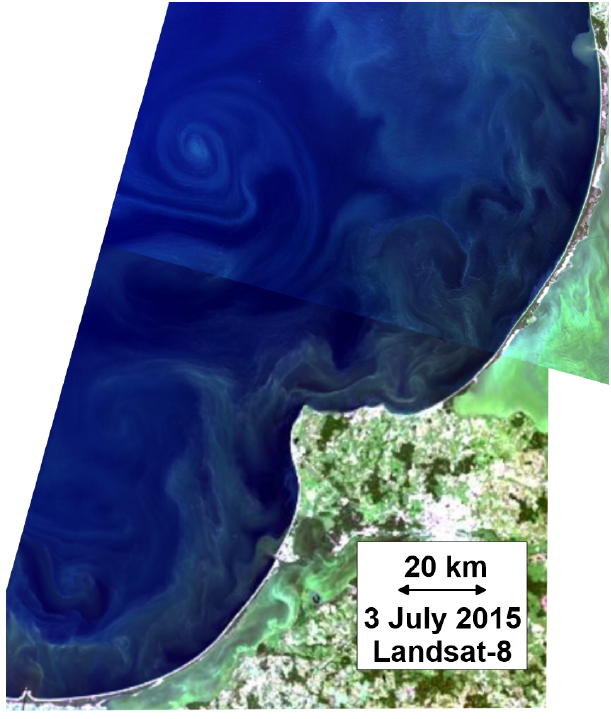
Figure 1. Landsat-8 true color image of the southeastern Baltic Sea with a prominent cyclonic spiral located at a distance of about 60km to the north-northwest of Cape Taran. The image was down- loaded from https://eos.com/landviewer (last access: 24 June 2018), ©Copyright 2019, EOS DATA ANALYTICS, Inc ©OpenStreetMap contributors 2019. Distributed under a Creative Commons BY-SA